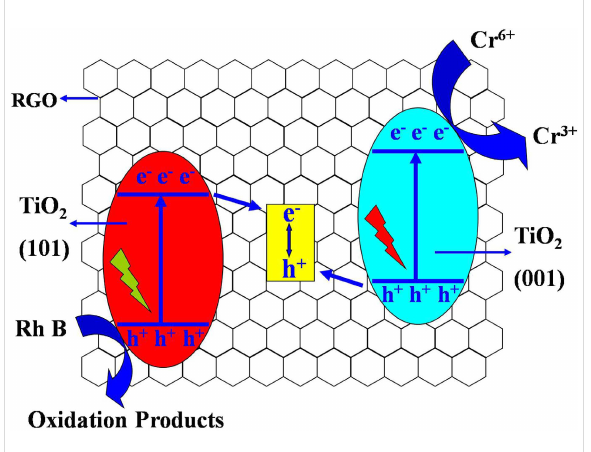
Figure 8: RGO–TiO 2 core–shell Z scheme for photocatalytic reduction of Cr(VI). Reprinted from [134], an article distributed under